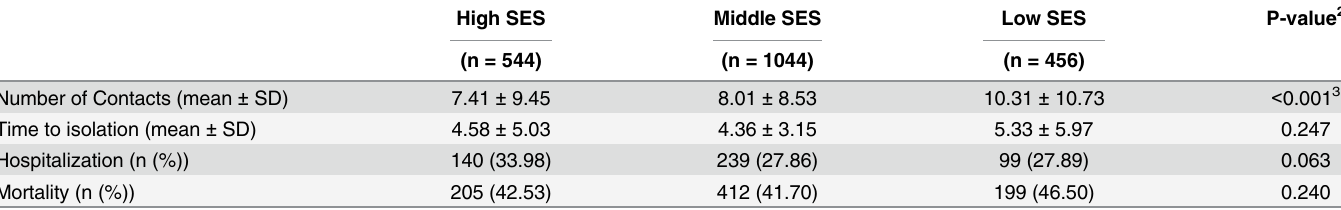
Table 2. Key factors of Ebola transmission based on socioeconomic status (SES) of probable and confirmed cases 1 .